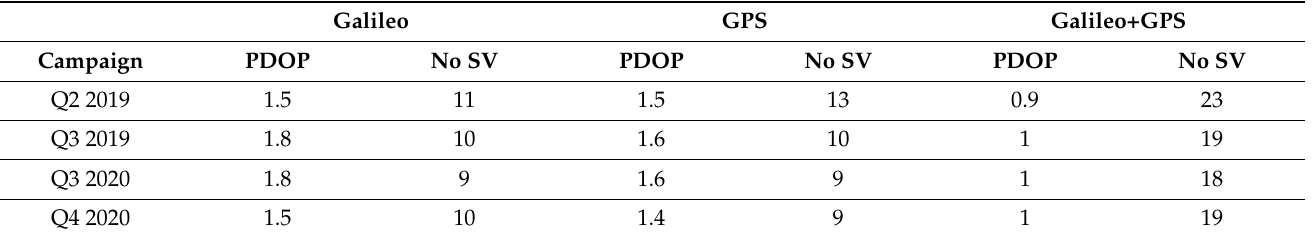
Table 8. Average PDOP and maximum satellites number during the aerial data-collection campaigns.